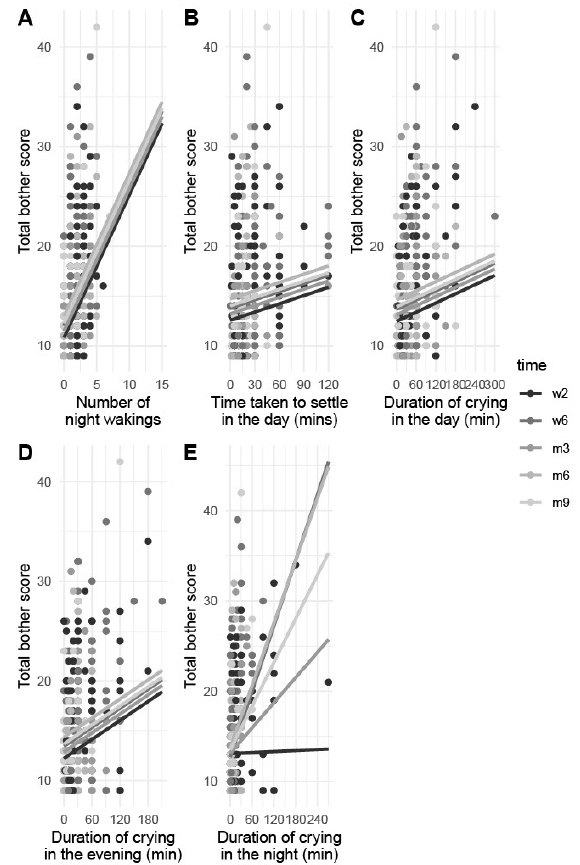
Figure 1. Linear mixed models showing the relationship between total bother scores and night waking frequency ( A ), time taken to settle in the day ( B ), duration of crying in the day ( C ), evening ( D ) and night ( E